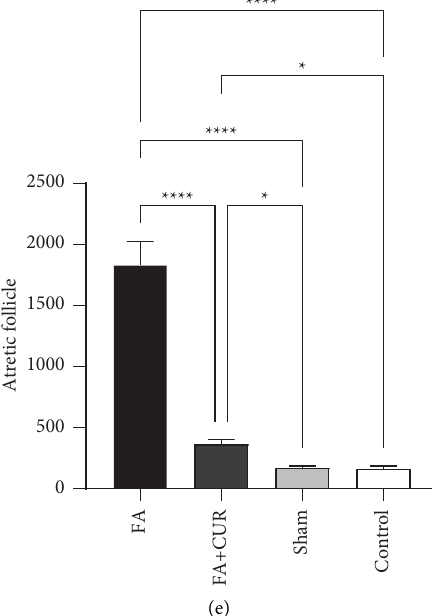
Figure 2: A comparison of the number of ovarian follicles among study groups. Each column presents the mean number ± SD of primordial (a), primary (b), secondary (c), graafan (d), and atretic follicles (e) in study groups. P < 0 . 05 were considered statistically signifcant. FA: formaldehyde, CUR: curcumin, and SD: standard deviation. ∗ p � 0 . 02, ∗∗ p � 0 . 009, and ∗∗∗ p < 0 . 0001. We used GraphPad Prism software